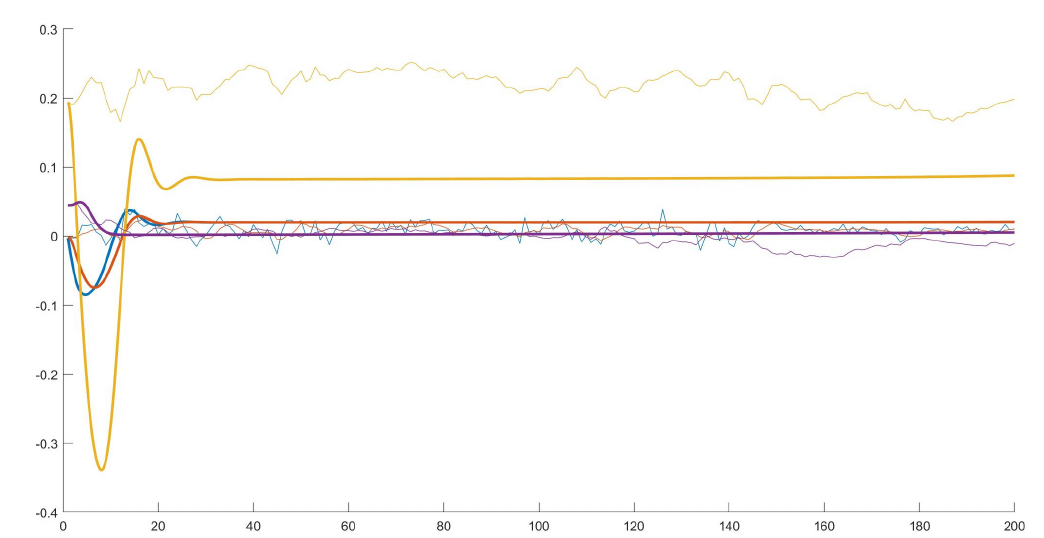
Figure 5. Time series obtained with parameters of calibration 1, that displays convergence to the long-run equilibrium. Legend: blue = rate of growth, red = expected rate of growth, yellow = share of saved income, violet: trade to income ratio. Thick line: model, normal line: data.